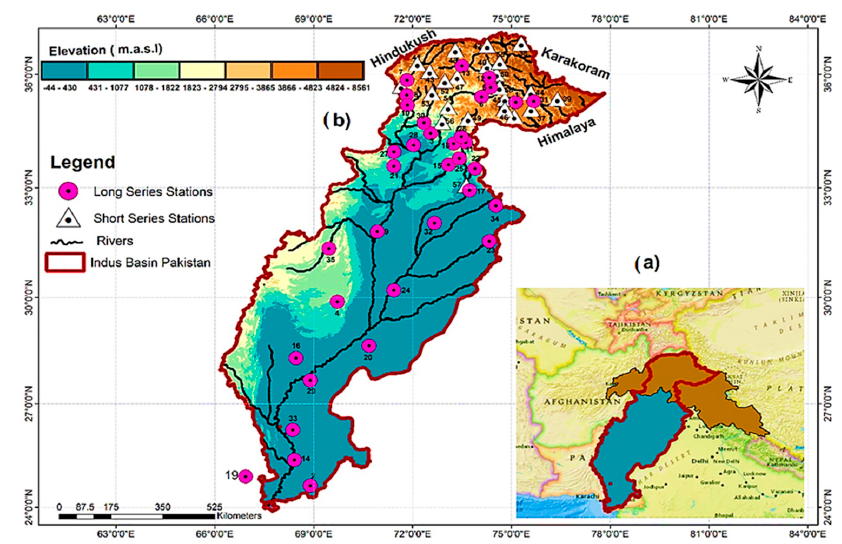
Figure 1. ( a ) The transboundary Indus River Basin indicating Upper Indus Basin (brown), Lower Indus (blue), and demarcation of the study area (red boundary). ( b ) Locations of the meteorological stations used in the study. Pink circles show the longer time series (1979–2015), and triangles indicate high-altitude stations with shorter time series (1994–2015). Note that the color scheme in ( b ) represents the elevation variation in the study area. The study stations’ geographic details are given after the numbers shown in ( b ) in Supplementary Materials as Table S1. Adapted with permission from ref. [43].